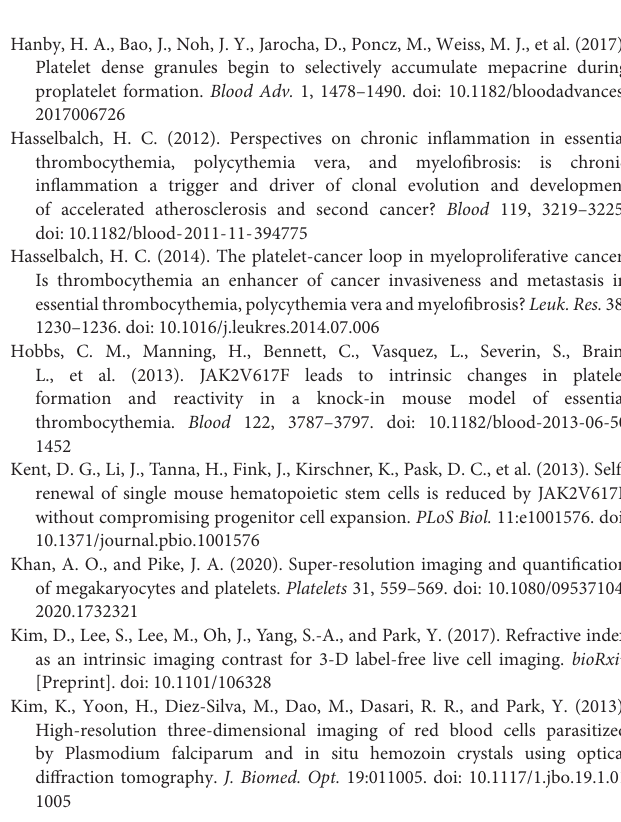
FIGURE S1 | Four percentage PFA fixation on platelets at varying time scales. (A–E) Morphological and biochemical parameters affected by PFA fixation (A) Surface area ( P = 0.3263, 0.0010, 0.0083), (B) Volume ( P = 0.4913, < 0.0001, 0.0004), (C) Sphericity ( P = 0.1521, 0.0027, 0.0103), (D) RI ( P = 0.4214, 0.9495, 0.6858), and (E) Dry mass ( P = 0.7976, 0.0005, 0.0001). Paired two tailed t -test was performed for all, n = 30. RI: Pink: 1.3444–1.3525, blue: